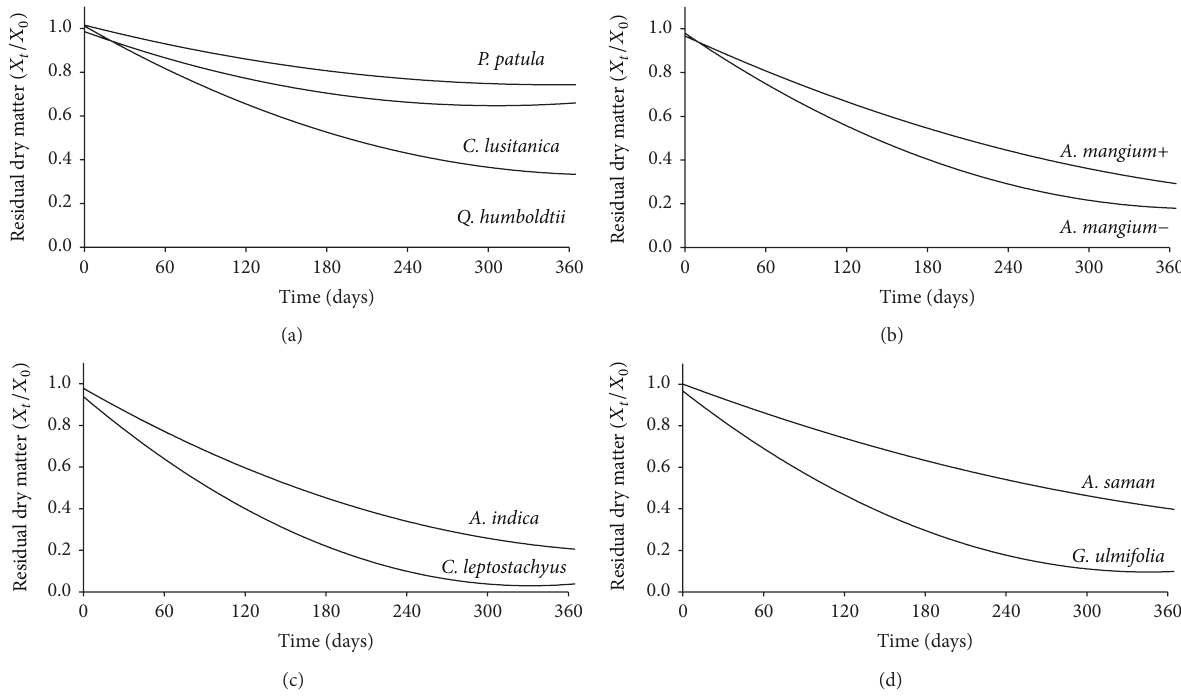
Figure 1: Residual dry matter ( 𝑋 𝑡 /𝑋 0 ) of leaf litter from restoration projects conducted in different regions of Colombia: (a) Forest of Q. humboldtii and plantations of P. patula and C. lusitanica in humid highlands degraded by overgrazing; (b) plantations of A. mangium established in degraded soils by alluvial mining (+: with soil tillage, − : without soil tillage); (c) plantation of A. indica and successional forest of C. leptostachyus in degraded dry lowlands; (d) silvopastoral systems with A. saman and G. ulmifolia in dry lowlands. Table 2: Indices calculated for leaf litter potential return ( 𝐴 ), leaf litter accumulation ( 𝐹 ), leaf litter real return (LLRR = 𝐴𝑘 𝑗 ), and real return of C (RRC = LLRR × C content ((%)) (expressed in Mgha − 1 yr − 1 ) in restoration projects conducted in Colombia. MRT 𝑗 : mean residence time (yr) and 𝑘 𝑗 : decomposition constant (yr − 1 ). 𝐹 values do not include the contribution of roots. 𝐴 𝐹 𝑘 𝑗 MRT 𝑗 LLRR RRC Source Ecosystem (Mgha − 1 yr − 1 ) Forest of Q. humboldtii Succession of C. leptostachyus 0.478 0.239